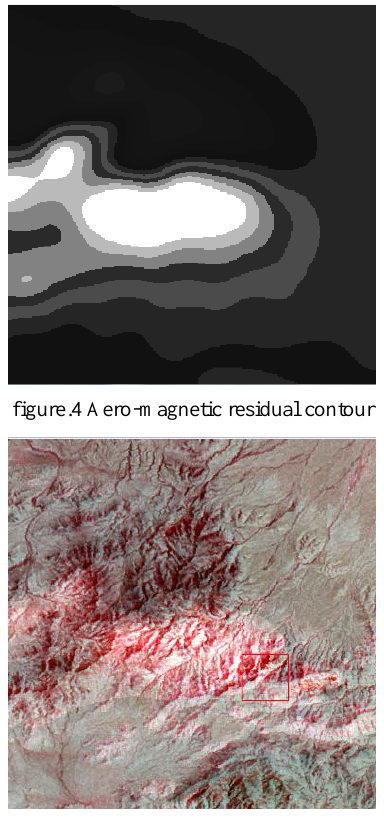
figure.5 fusion